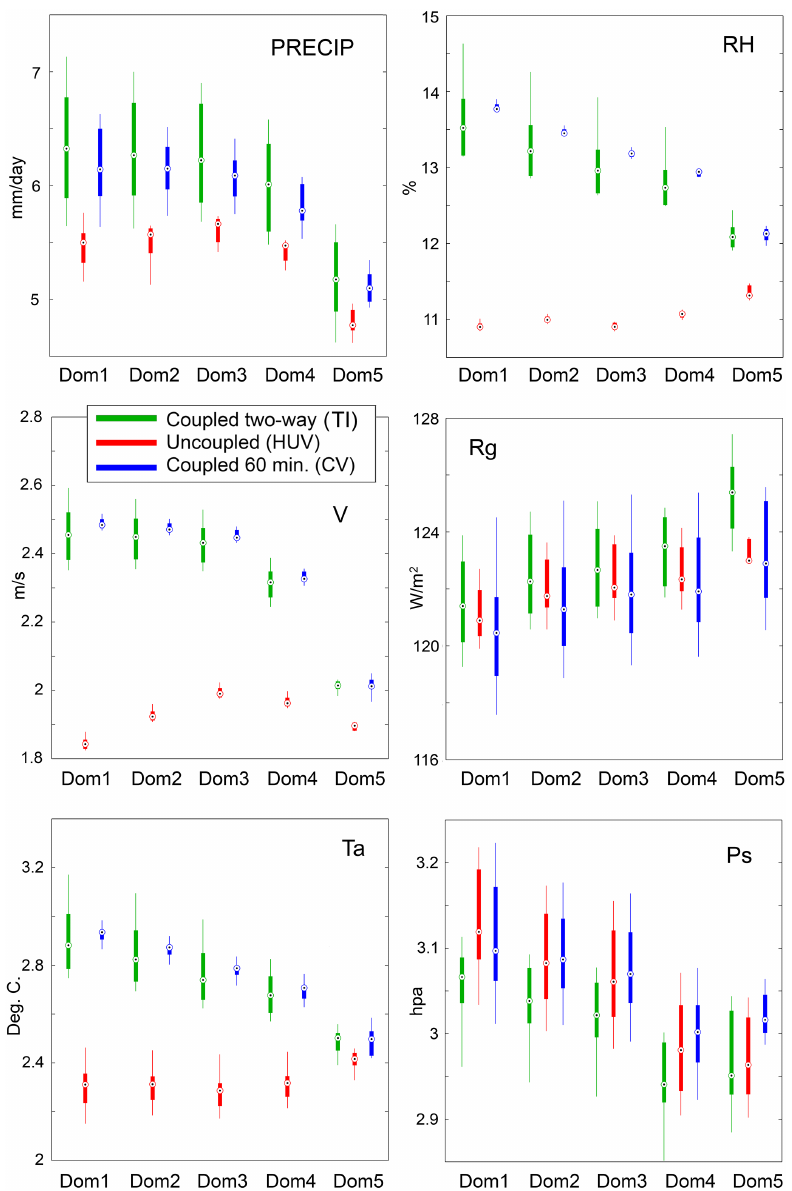
Figure 5. RMSE variability for the TI, HUV and CV simulations for each of the five test domains. The dots represent the median value, the box plots represent the 25–75th percentiles and the whiskers represent the entire data